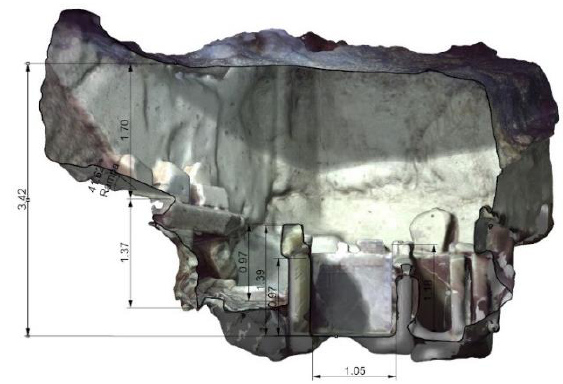
Figure 13: 3D visualizations of the tomb, 2018.